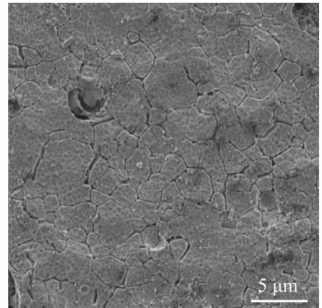
Figure 1. Scanning electron microscopy (SEM) micrograph of the bulk ultrafine-grained Ti31Mo